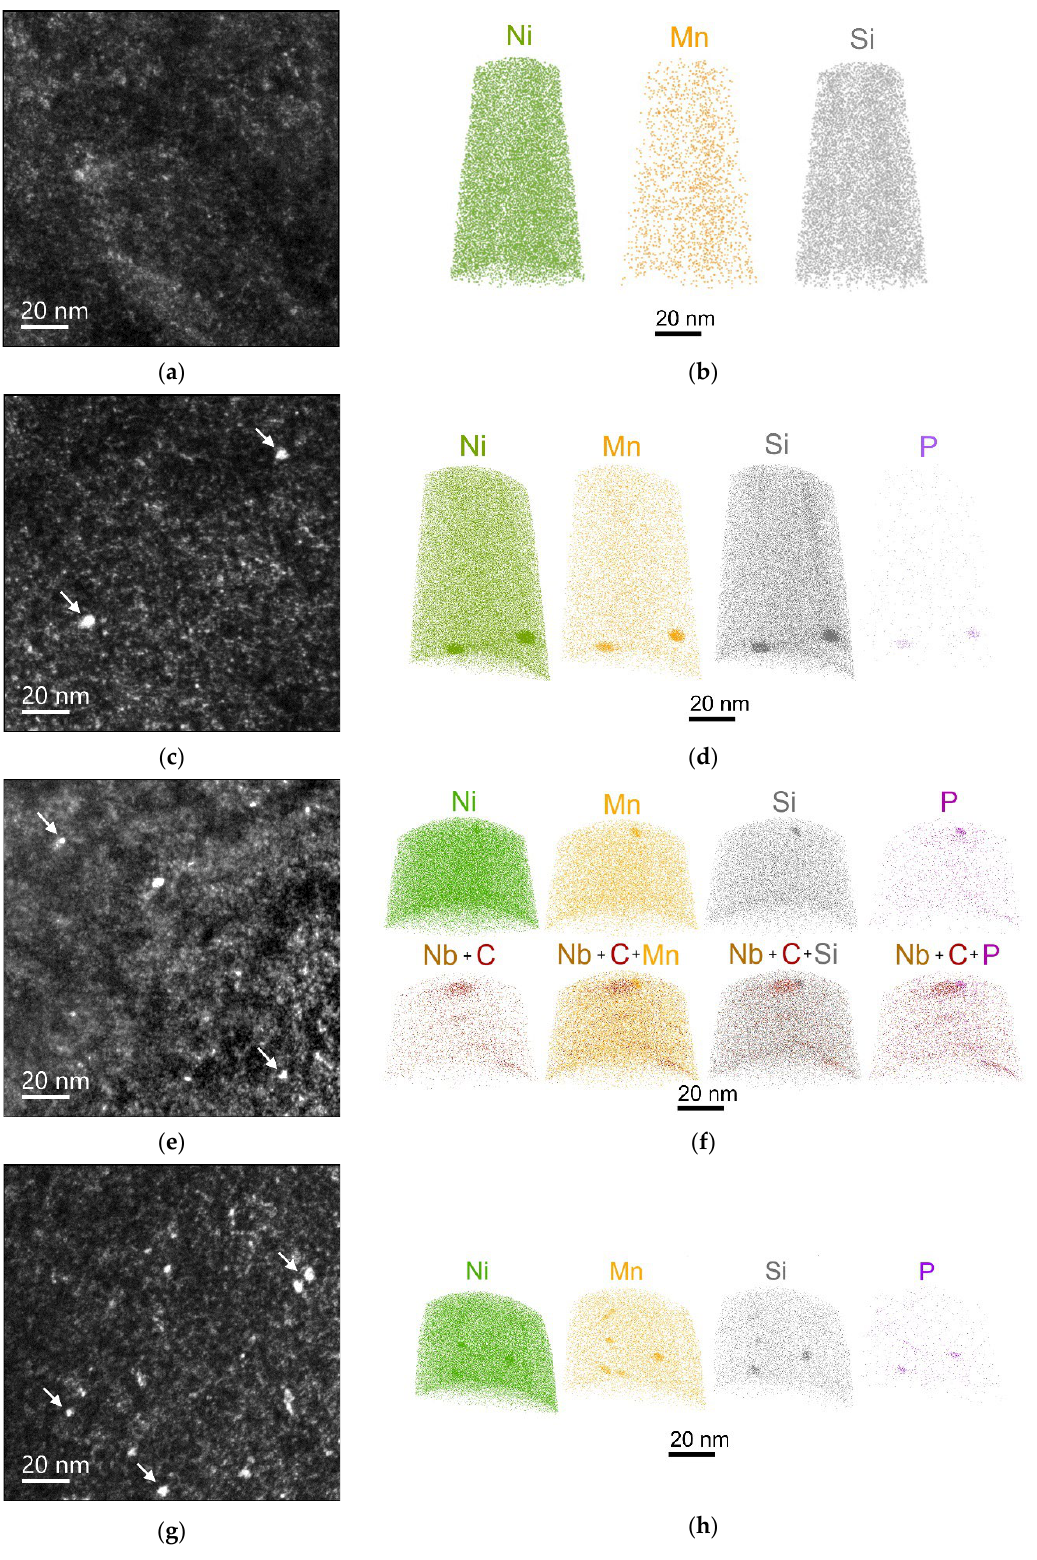
Figure 3. Typical dark-field TEM images in precipitates observation conditions ( a , c , e , g ) and typical APT maps of chemical element distribution ( b , d , f , h ) in the studied steels: HL ( a , b ), MM ( c , d ) and HH ( g , h ) irradiated up to fluence 120 × 10 22 n/m 2 , and HH steel ( e , f ) irradiated up to fluence 53 × 10 22 n/m 2 (arrows in TEM images indicate Ni-Si-Mn